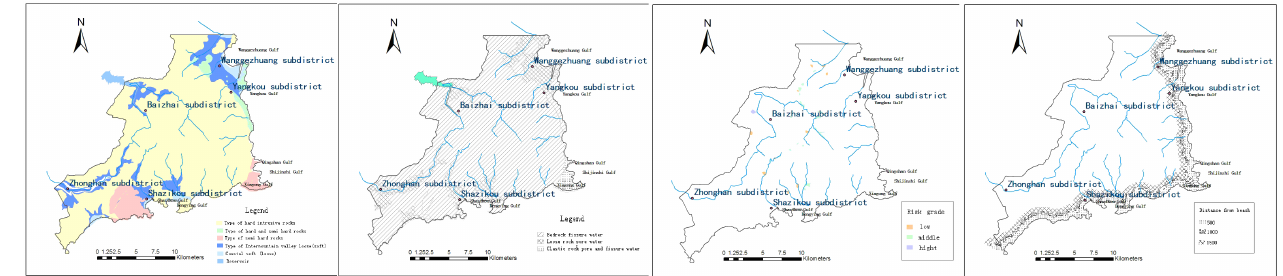
Fig. 5. Engineering geology map (a); hydrological geology map (b); Geologic hazard map(c); Proximity to beach map (d).